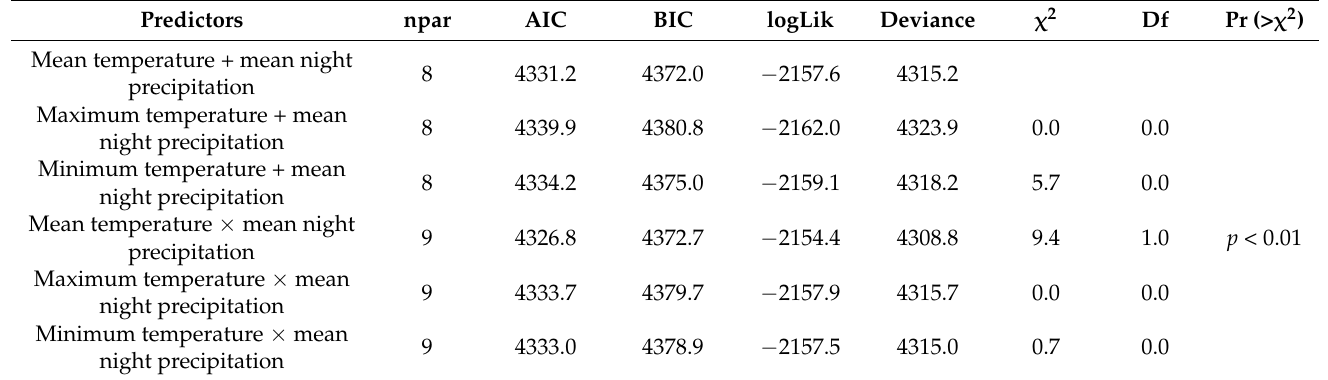
Table 3. The models with two predictors and interaction compared with the models without it.